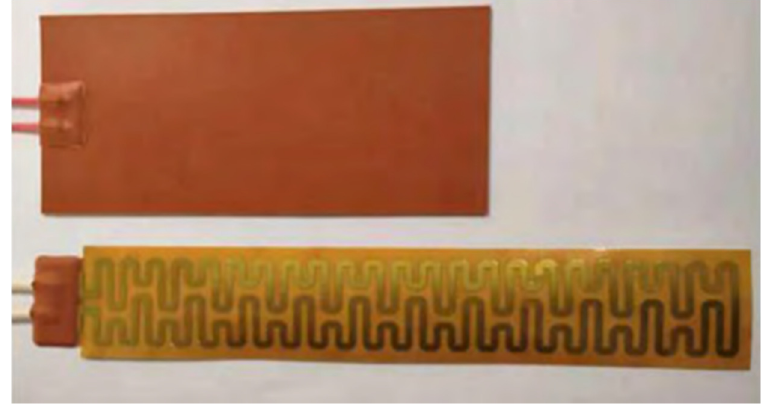
Figure 10. Electric heating film.